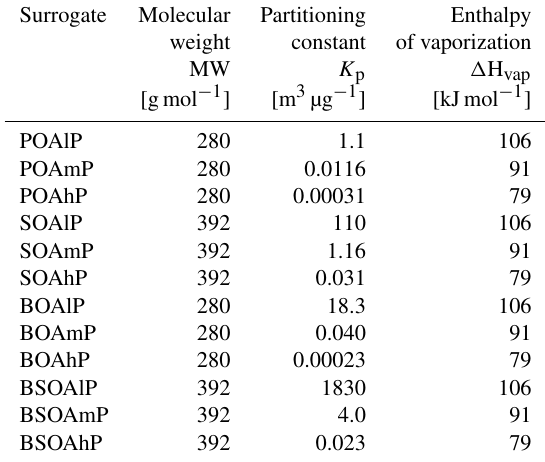
Table 8. Properties of primary and aged SVOC used in the H 2 O mechanism, extended version of Table 3 in Couvidat et al. (2018). Surrogate